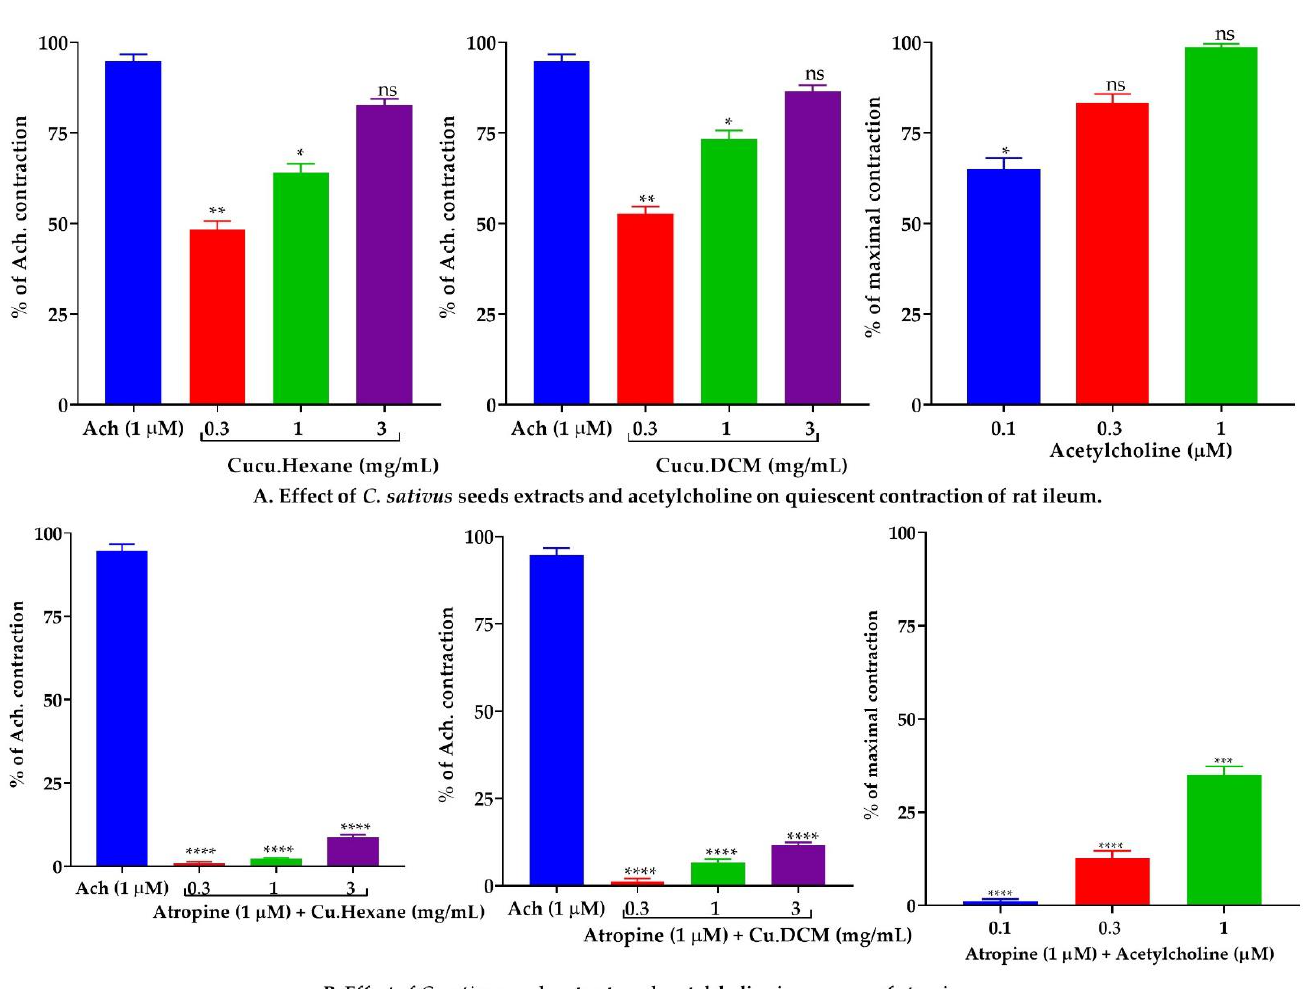
Figure 7. The effect of n -hexane, DCM, and acetylcholine (Ach.) was tested in rat ileum preparations in the ( A ) absence and ( B ) presence of atropine. Values are expressed as the mean ± SD ( n = 4). The data were evaluated using one-way ANOVA followed by Dunnett’s test in comparison to Ach. Results were considered significant at p < 0.05. (* p < 0.05, ** p < 0.01, *** p < 0.001, **** p < 0.0001, ns: